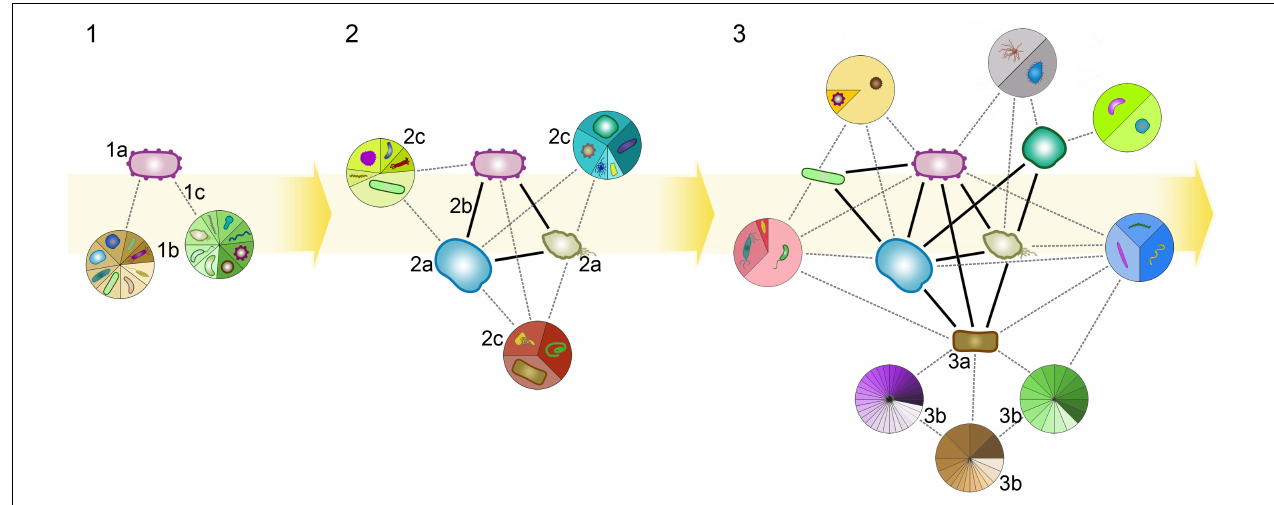
FIGURE 4 | A potential scenario of microbial community assembly driven by deterministic and neutral factors. The colonization of a new habitat may set off from a specific species (purple founder cell). Options for subsequent partners may have a wide range (pie charts), that correspond to functional types or guilds (color schemes) that fit into the emerging interaction profile (dotted lines). The particular species recruited from a guild can be due to random chance. Initially, many alternative pioneers are possible (1b), giving rise to multiple alternative topologies (not shown). Once a recruitment happens (2a), the interaction is realized (2b; solid lines). After integration, some species can be exchanged (by another species from the same pie chart) without changing the community topology or functional profile. As species gets integrated into the community (1a, 2a, 3a), the number of further options often declines (2c), as the community presents an increasingly